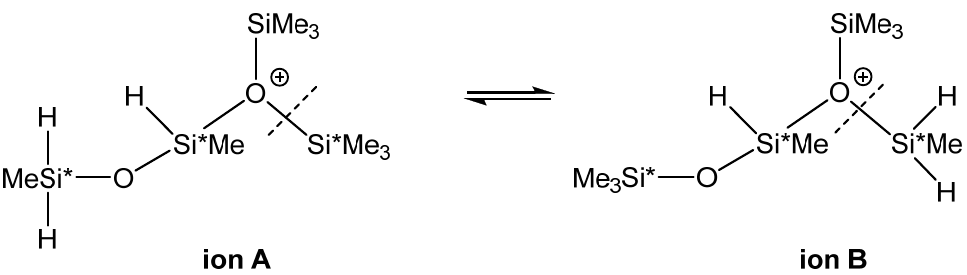
Table 1. Thermodynamic functions and hydrogen–boron bond length of Me n SiH 3-n , n = 1–3, com- plexes with TPFBP and thermodynamic functions of the formation of some siloxonium ions . Δ H 298